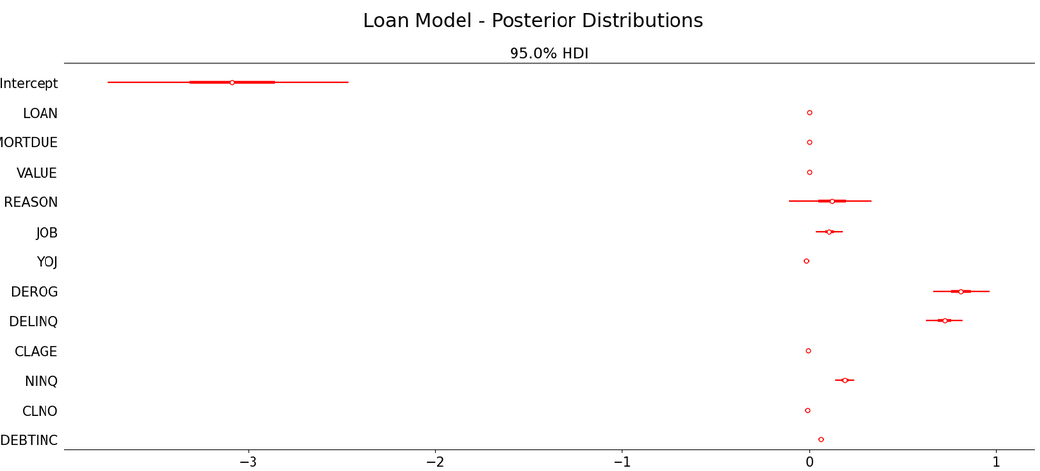
Figure 7. Posterior distribution forest plot.